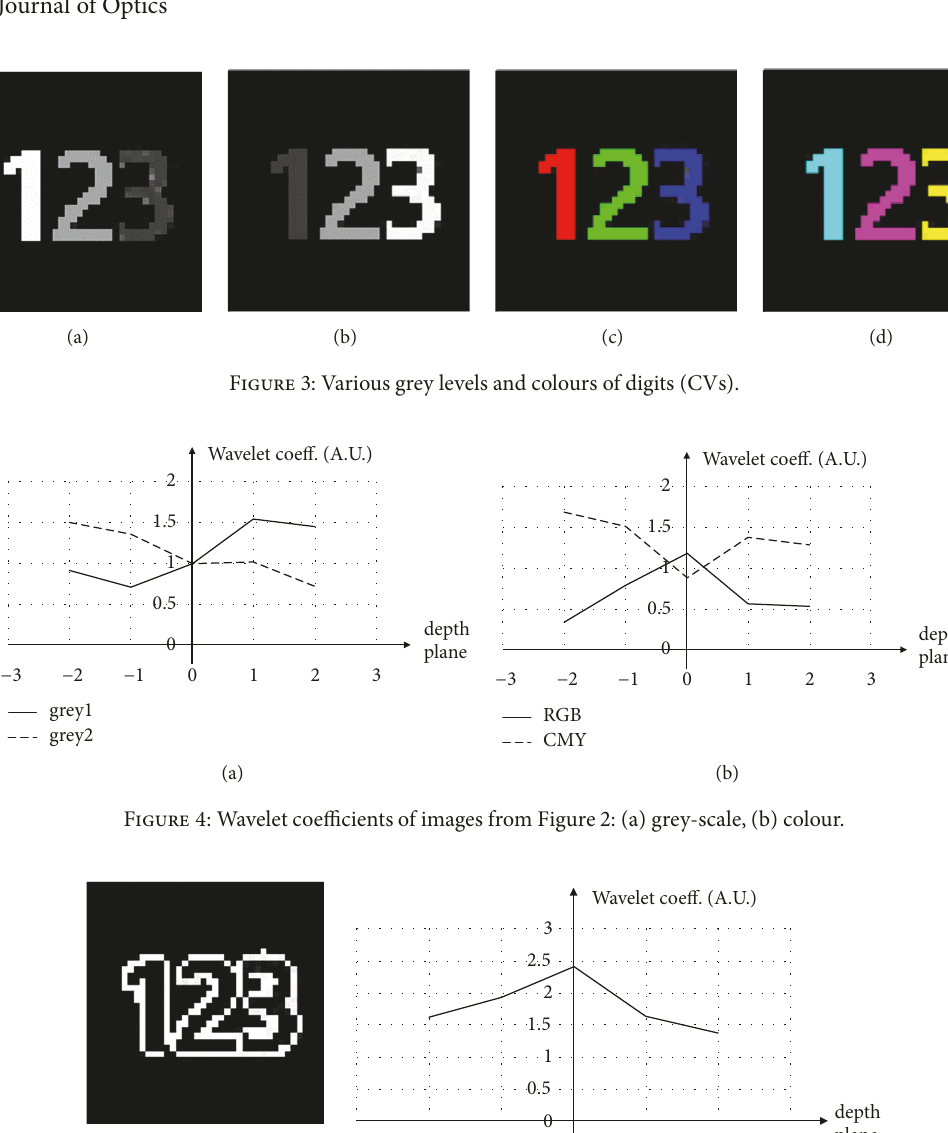
Figure 5: (a) Normalized image (CV). (b) Wavelet coefficients of normalized